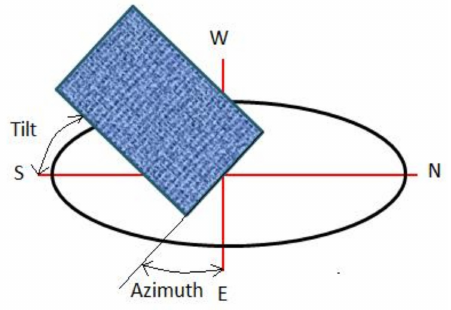
Figure 10. System’s tilt and azimuth angles representation.